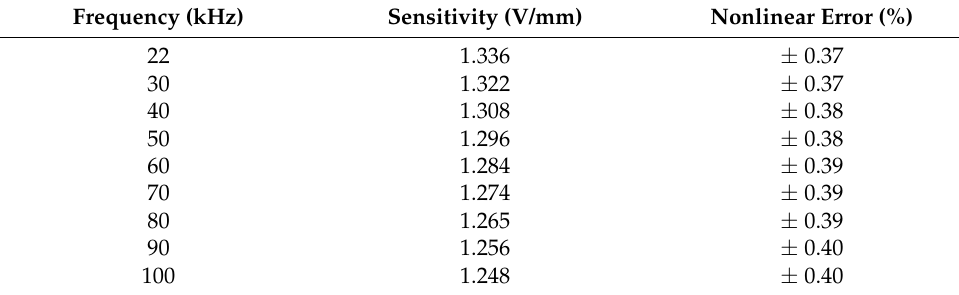
Table 3. Sensitivity and nonlinear error of